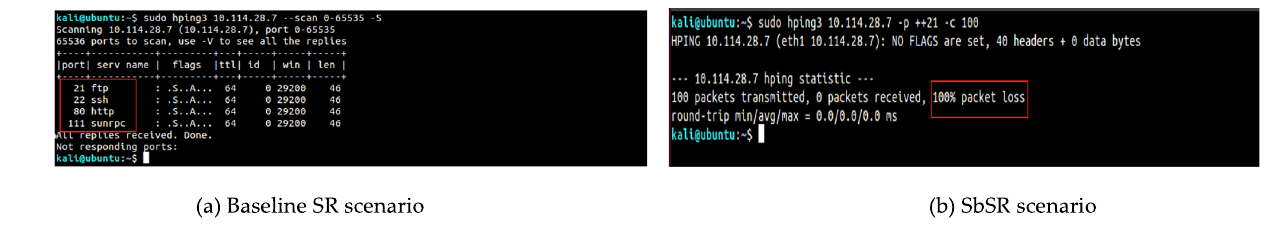
Figure 10. Port scan test ( a ) Baseline SR scenario ( b ) SbSR scenario